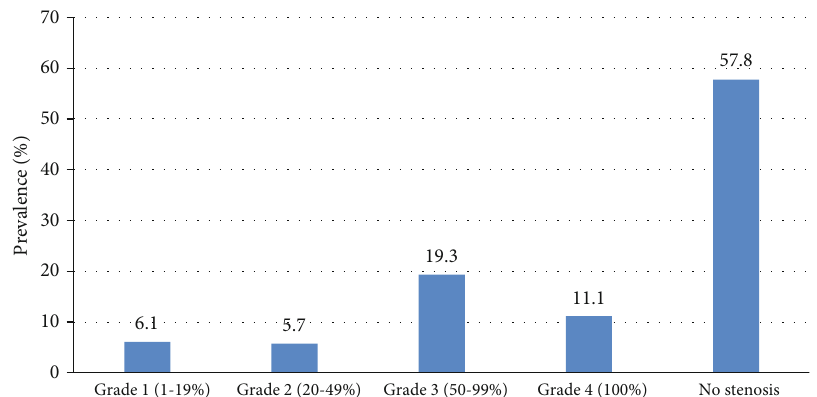
Figure 1: Degree of stenosis on color Doppler ultrasonography in patients with T2DM. Grade III and IV stenoses were de fi ned as peripheral artery